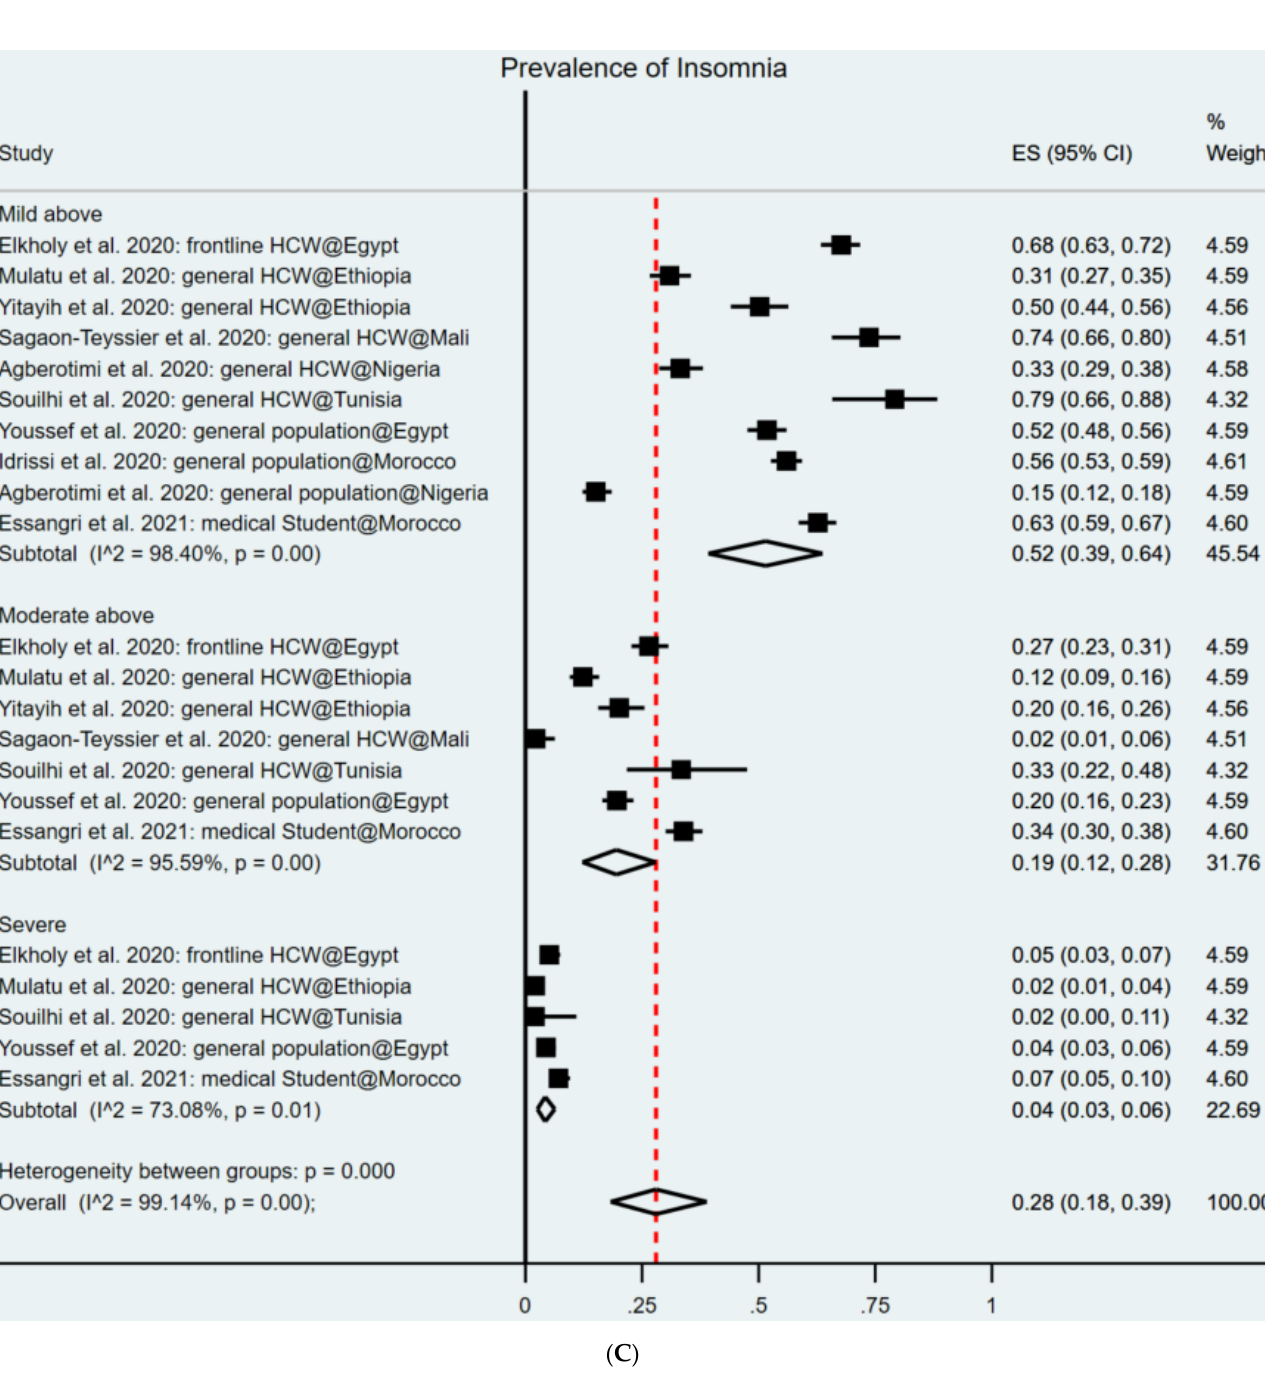
Figure 2. ( A ) Forest plot of the prevalence of anxiety. ( B ) Forest plot of the prevalence of depression. ( C ) Forest plot of the prevalence of insomnia. Figure legend: the square markers indicate the prevalence of insomnia at the different levels for different populations. The size of the marker correlates to the inverse variance of the effect estimates and indicates the weight of the study. The diamond data markers indicate the pooled prevalence.